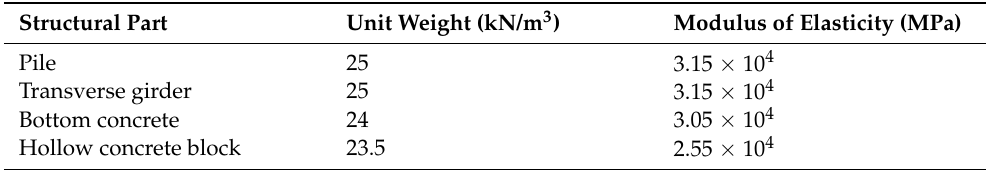
Table 1. Material parameters of physical